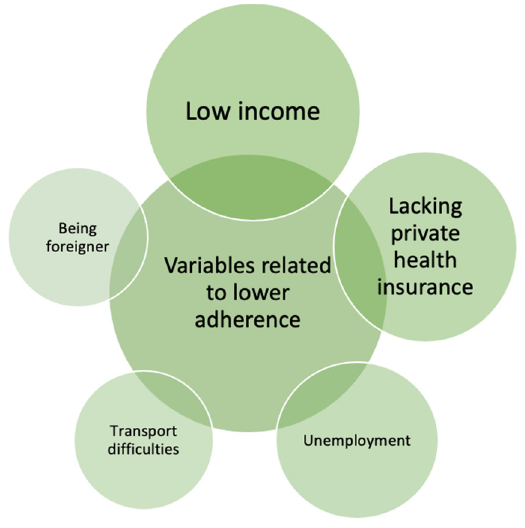
Figure 2. Variables associated with low socioeconomic level and lower adherence.